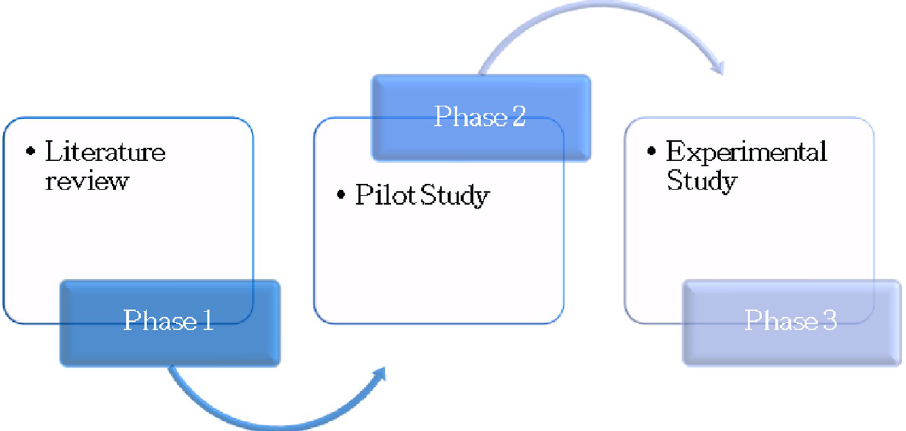
Fig 2. The three phases of the research